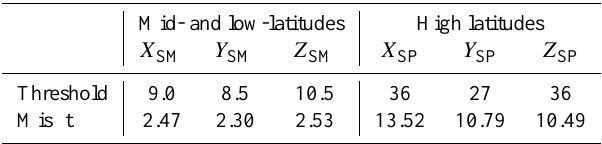
Table 2. Thresholds and misfit values obtained when estimating ˆ B i from selected satellite data. Mid- and low-latitudes are defined by magnetic latitudes in between ± 55deg. Values are given in nT.